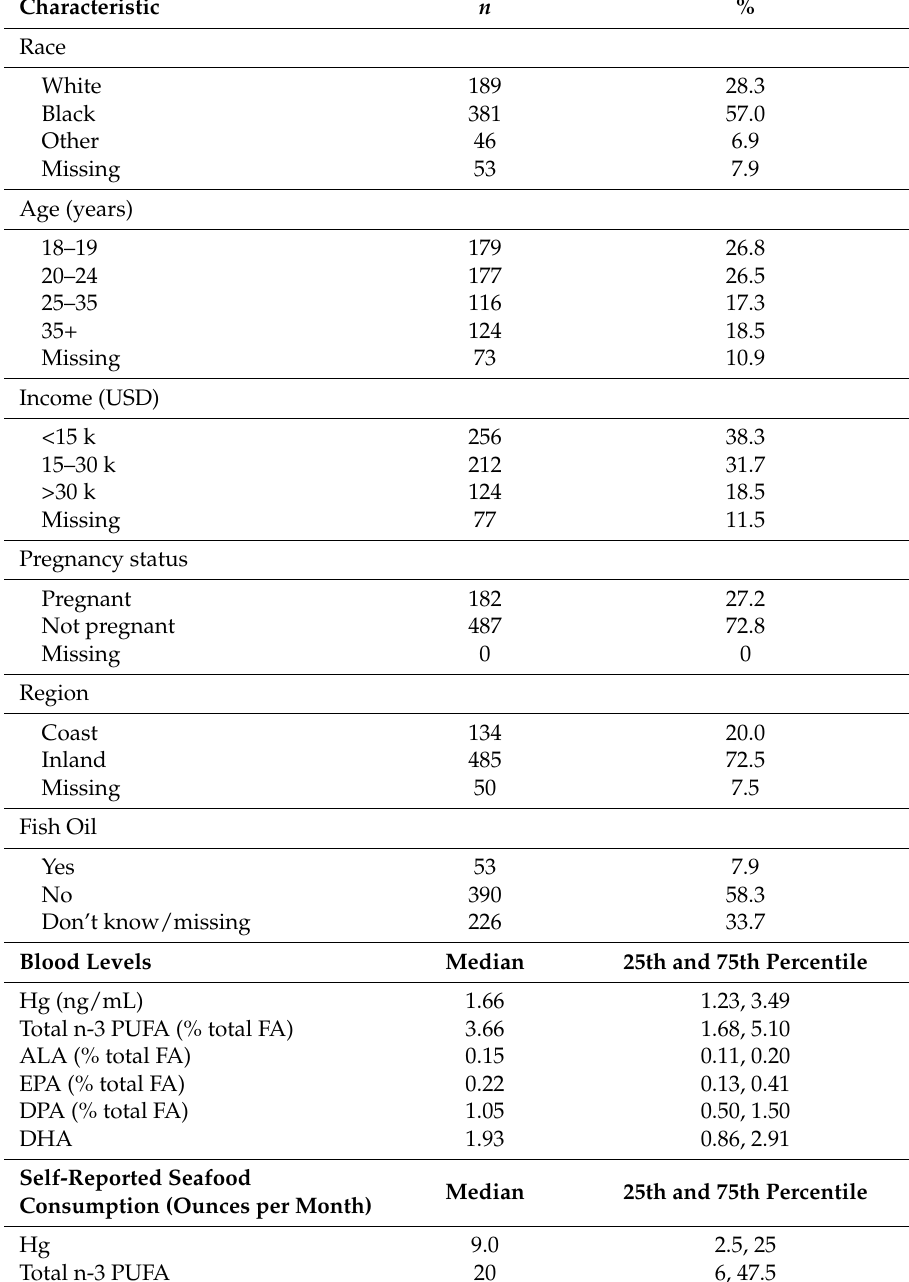
Table 1. Descriptive characteristics of Gulf Resilience on Women’s Health (GROWH) participants, n = 669.